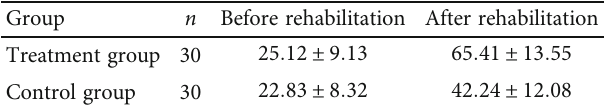
Table 4: Comparison of Barthel index in daily living ability.